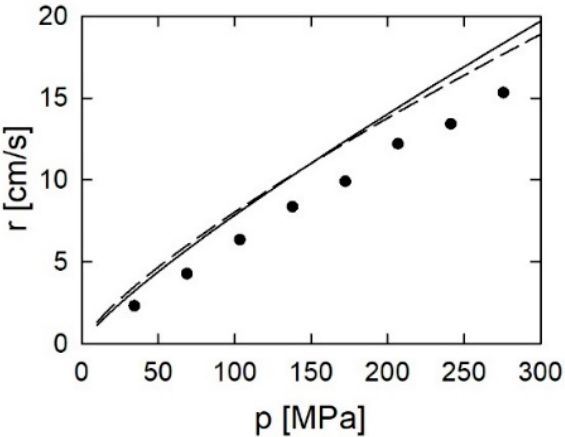
Figure 16. Comparison of the burning rate values obtained for the 5/7NA propellant (solid line) and the 12/7 propellant (dashed line), and strand burner test results for the M10 propellant (circles) [25].